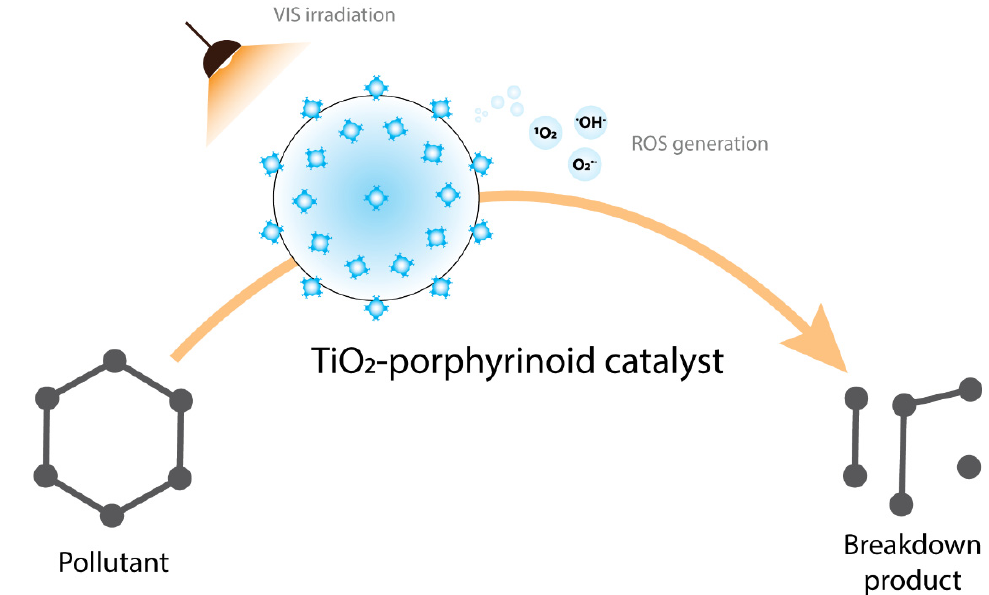
Figure 11. The applicability of porphyrinoids and titanium(IV) oxide-based hybrid materials as catalysts in the photodegradation studies of various pharmaceutically active ingredients.